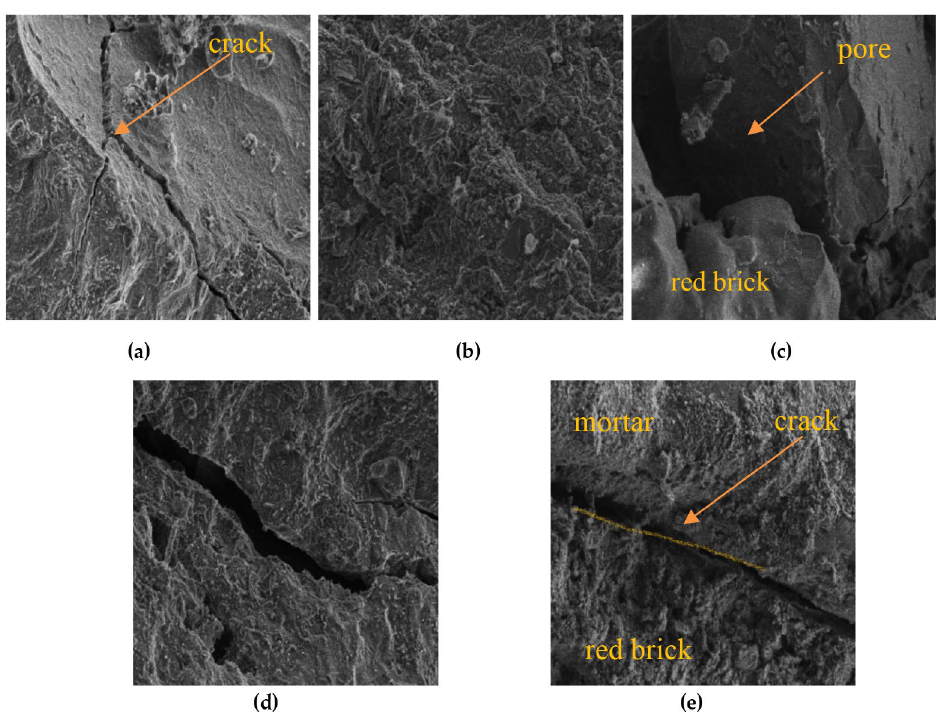
Figure 8. Electron microscope scanning SEM image: ( a ) Natural coarse aggregates; ( b ) Red brick aggregate surfaces; ( c ) Red brick aggregates; ( d ) Red brick aggregate cracks; ( e ) Red brick aggregate and mortar transition